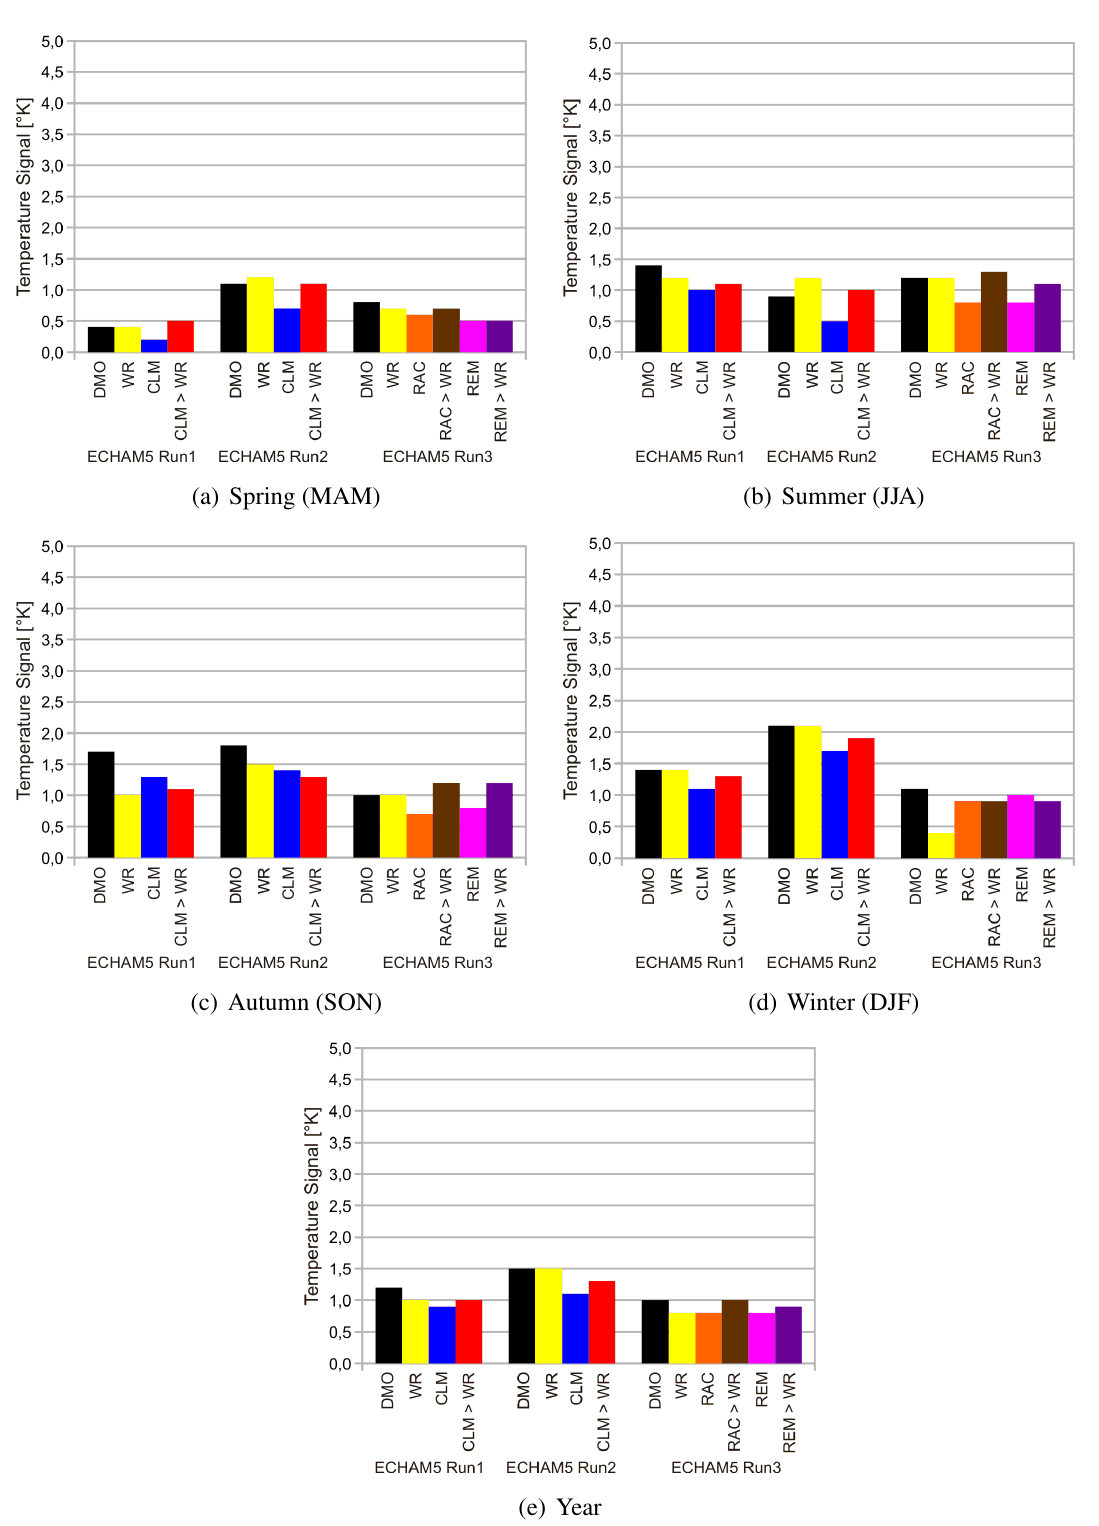
Figure 2. Comparison of the climate signals of 2 m mean temperature, computed as the difference of the 2021–2050 and 1971–2000 values. Based on northern